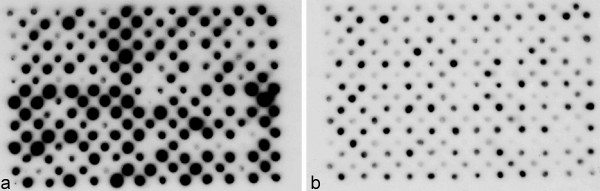
Screening by reverse Northern. One set of membranes is shown as an example. Each cDNA obtained from the SSH library was spotted onto a membrane. Membrane (a) and (b) were two identical membranes. Each blot was hybridized with 32P-labeled probes derived from 20 μg of total RNA. Membrane A was hybridized with total RNA from waterlogging-treated samples as a probe, and B was hybridized with total RNA from the control as a probe.